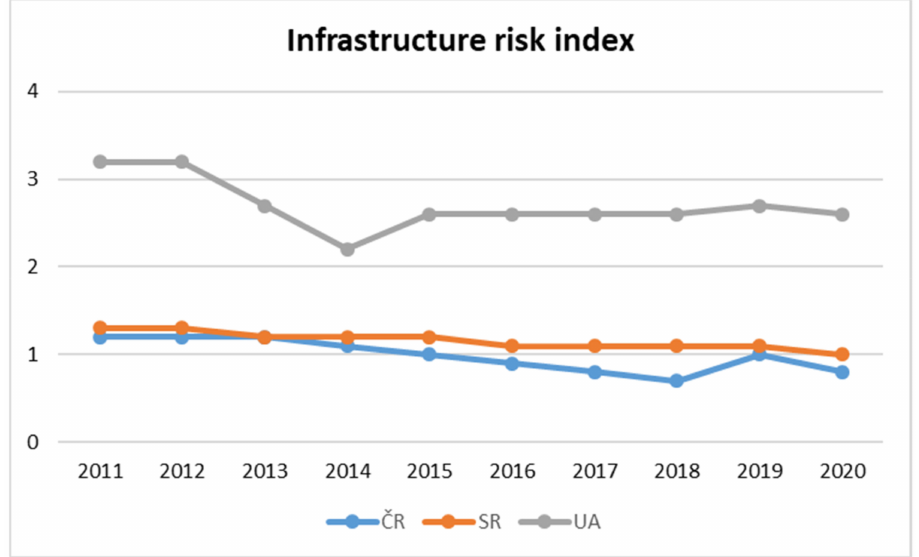
Figure 1. Development of infrastructure risk index in the SR, Czech Republic, and UA between 2011 and 2020